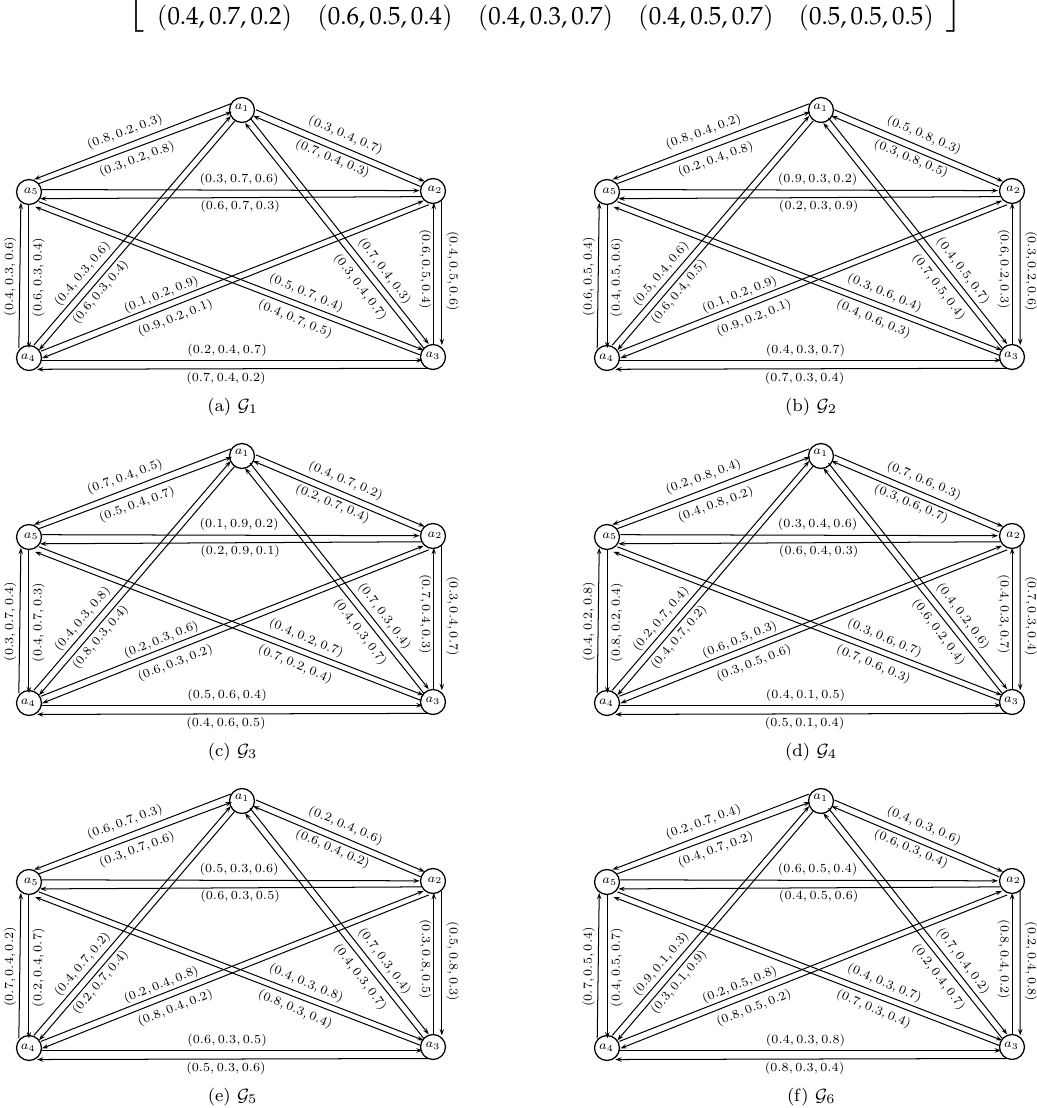
Figure 18: Spherical fuzzy digraphs. Figure 18. Spherical fuzzy